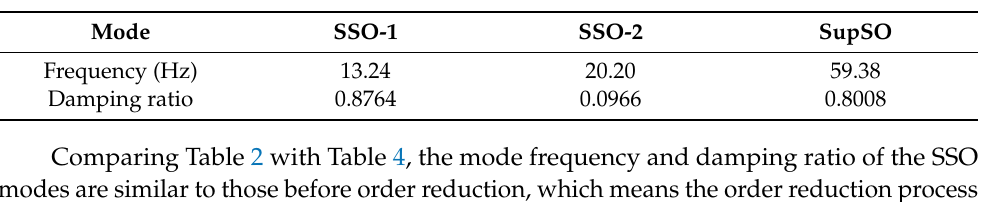
Table 4. Frequency and damping ratio corresponding to oscillation modes after order